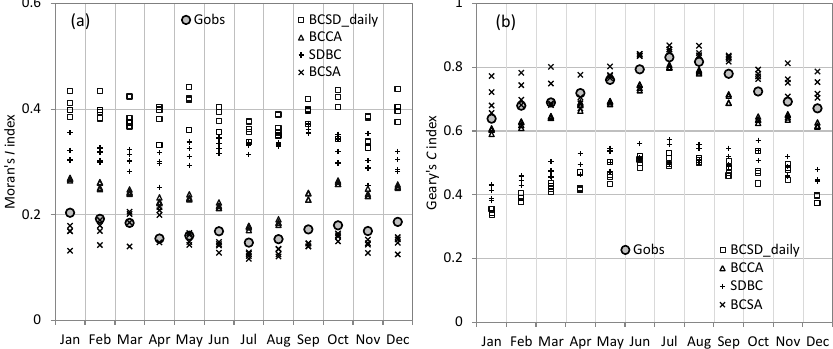
Fig. 17. Comparison of observed and simulated mean daily spatial correlation indices (a) Moran’s I and spatial variance indices (b) Geary’s C for each month. 4 GCMs are not separately represented but are indicated by the same marker for each downscaling method.